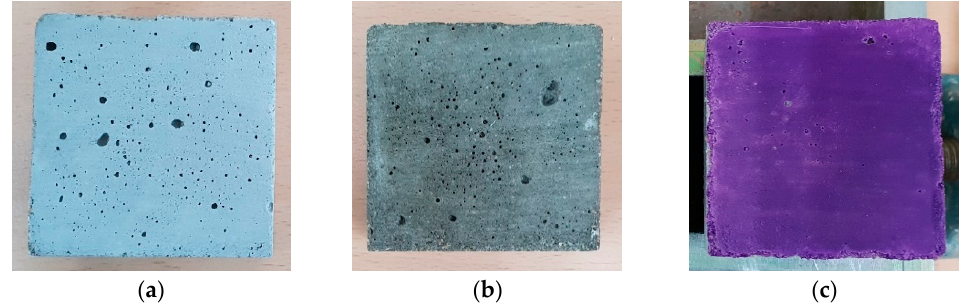
Figure 3. Specimens and coatings on the surface: ( a ) mortar surface; ( b ) prime coating; ( c ) MnNH 4 P 2 O 7 -based coating.